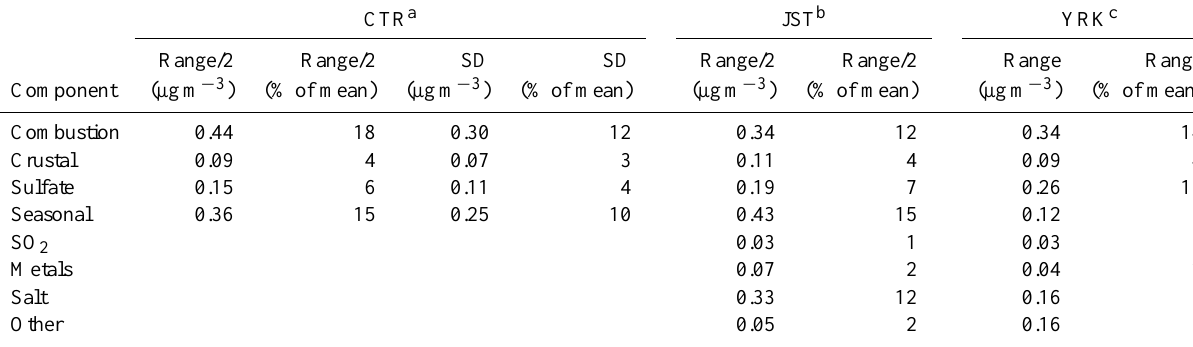
Table 4. Ranges of mean OC concentrations associated with each PCA component. The time period is 2009–2013. For each site, multiple methods were compared using a common set of days. For CTR (six methods), both the standard deviation and one-half the range of com- ponent mean concentrations are shown. For JST (three methods), one-half the range of component mean concentrations is shown. For YRK (two PCA methods), ranges are shown. YRK ranges are smaller than ranges for CTR and JST because no PMF analyses were carried out for YRK. The larger ranges for CTR and JST compared with YRK reflect the larger differences between PCA and PMF. CTR a JST b YRK c Range/2 Range/2 SD SD Range/2 Range/2 (µgm − 3 ) (% of mean) (µgm − 3